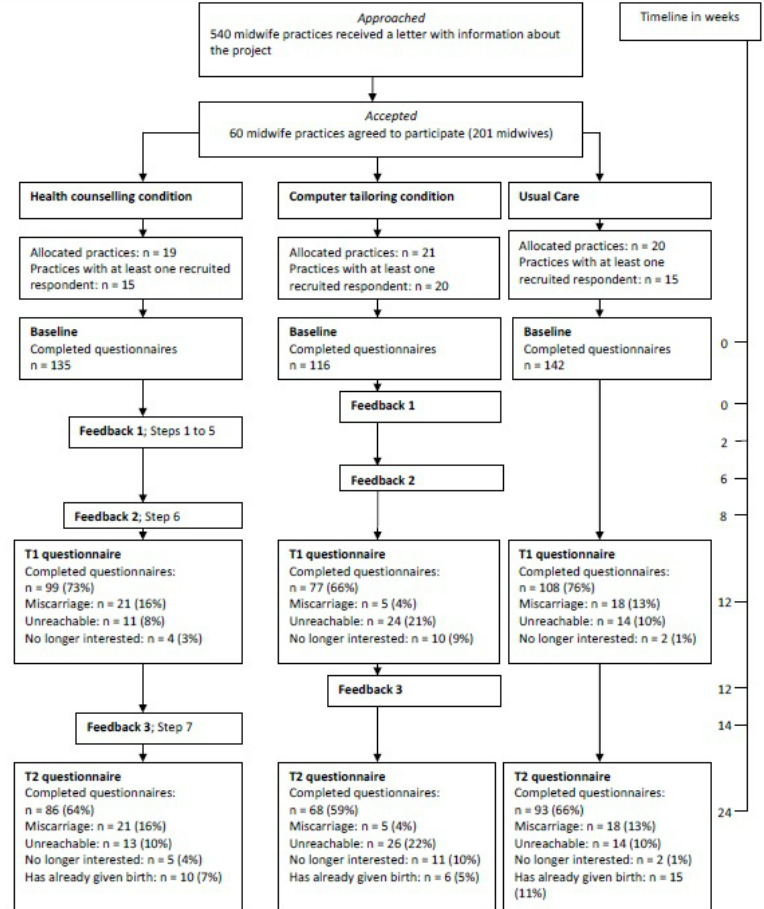
Figure 3. Flowchart of cluster randomized trial testing the effectiveness of health counseling and computer tailoring compared to usual